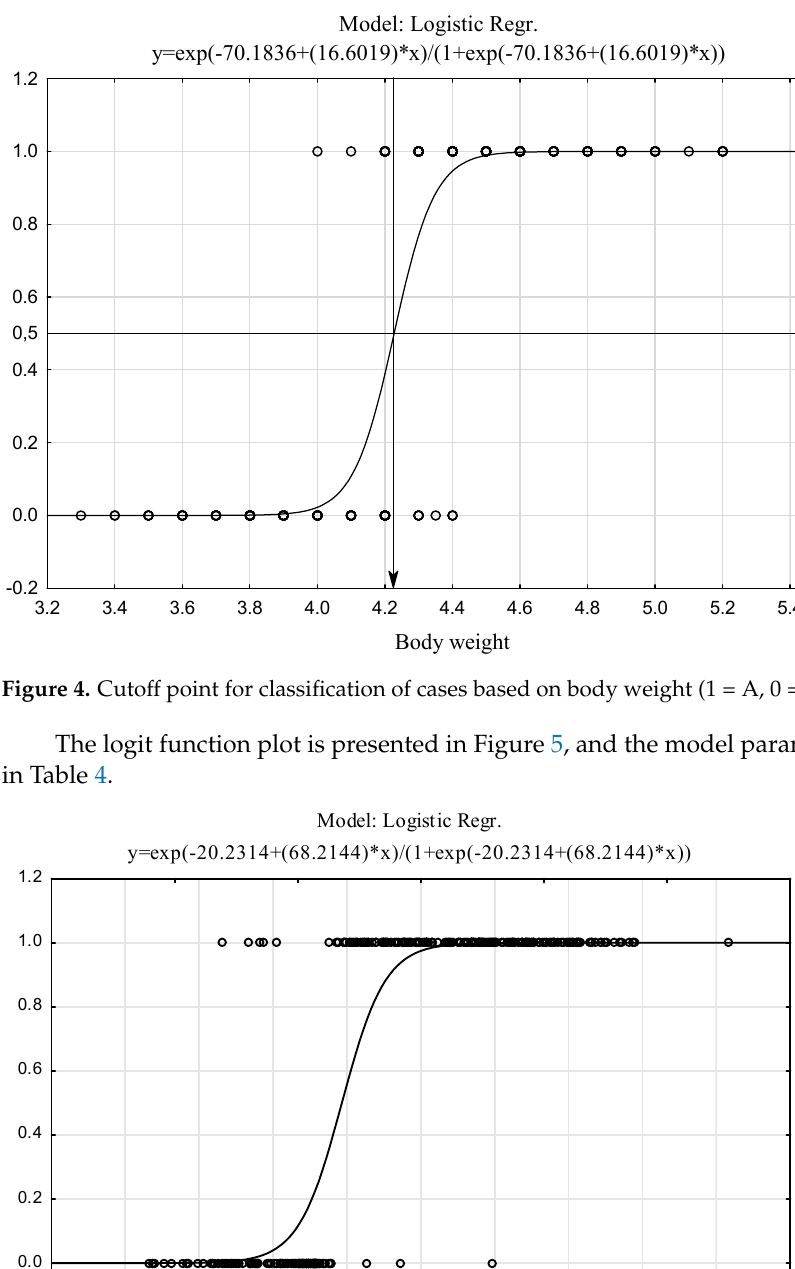
6 of 11 Table 2. Parameter evaluation in the logistic regression model in relation to body weight . N = 297 Total Loss: 55.7128 Chi 2 (1) = 290.06 p = 0.0000; Modeled p , Age = A Constant B0